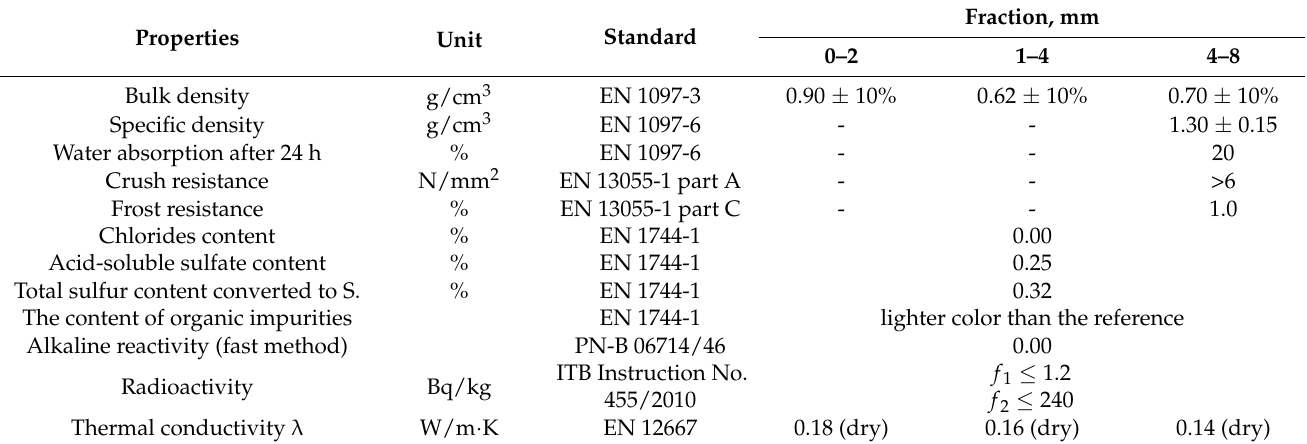
Table 4. Artificial lightweight aggregate fractions of 0–2, 1–4 and 4–8 mm [36].